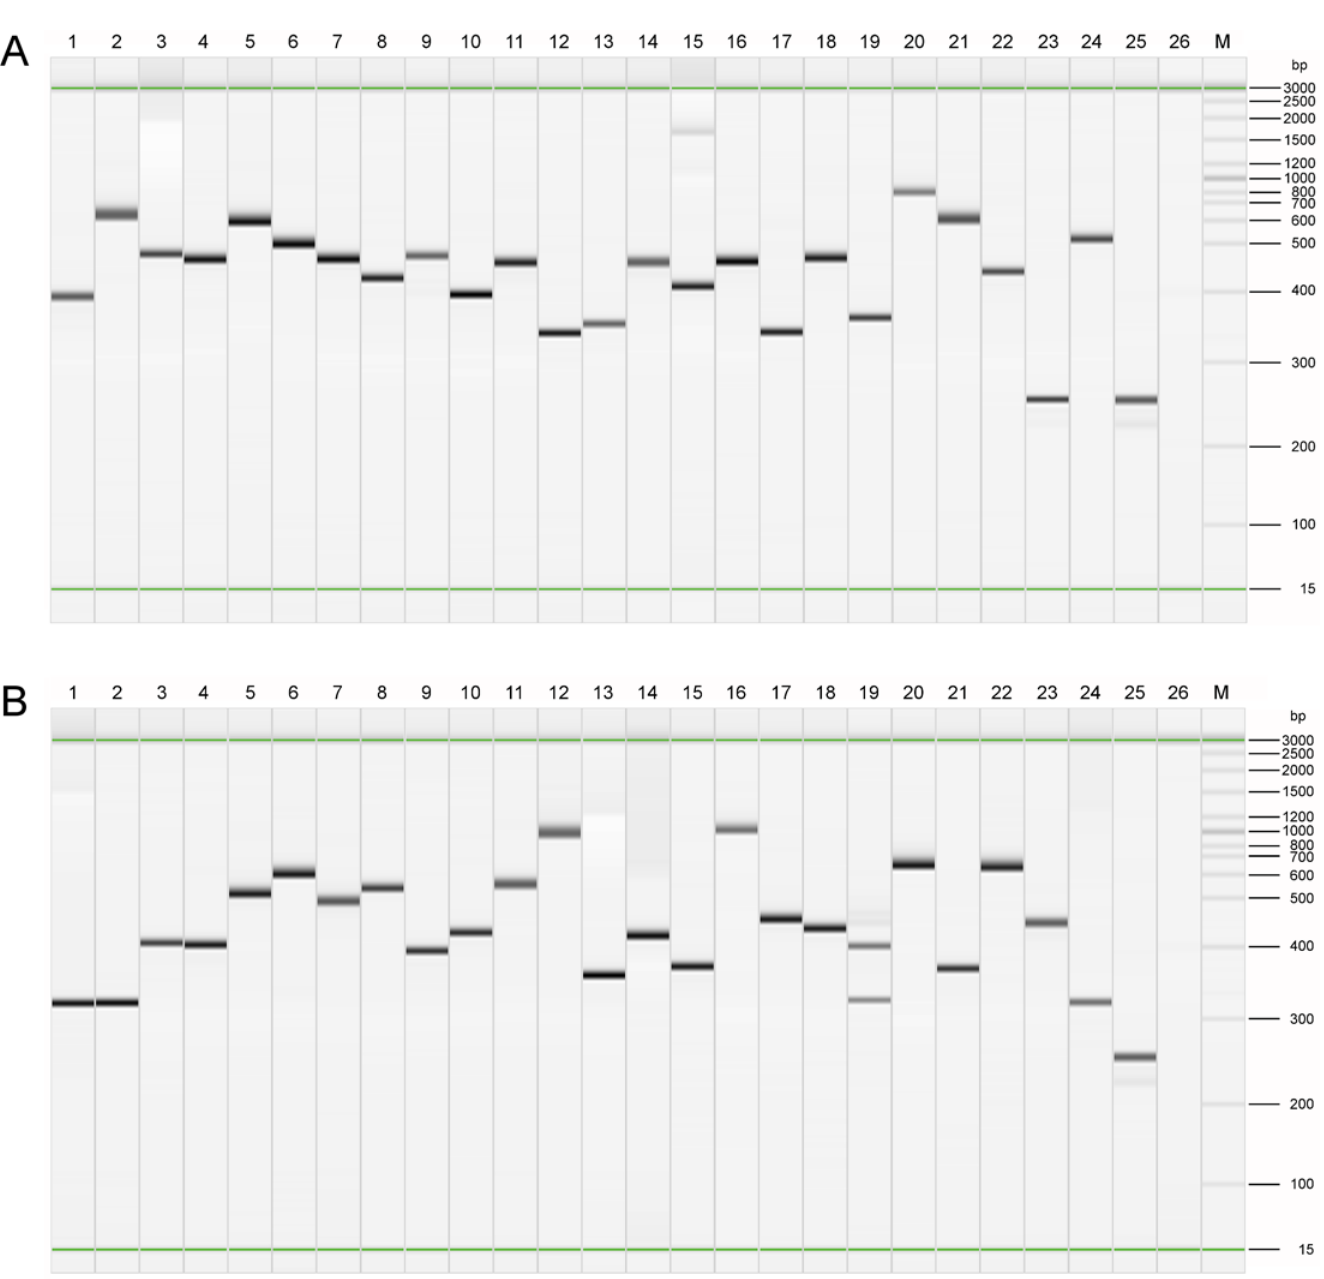
Fig 1. Colony PCR results presented as gel images. A cloned library fragments B Hyperphage packaged inserts. Lanes 1 – 24 randomly picked clones from three different libraries (A) and from the phage packaged library (B), Lane 25 Empty pHORF3 vector control without insert, Lane 26 No template control, M Size